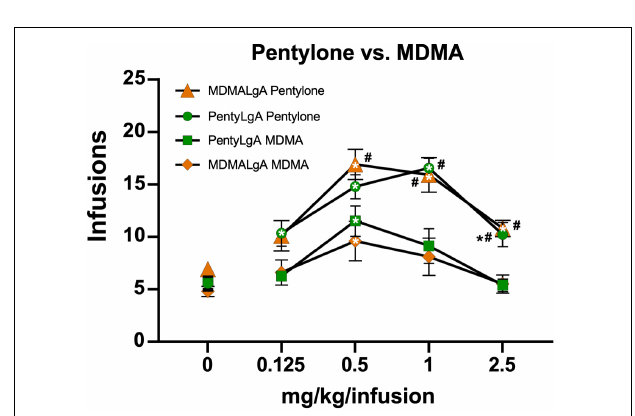
FIGURE 4 | Mean ( ± S.E.M.) infusions of Pentylone and of MDMA obtained by groups trained in LgA IVSA of pentylone ( N = 8–9) or MDMA ( N = 10). A significant difference from saline, within group, is indicated with *, a significant difference from MDMA, within each LgA group, is indicated with #.